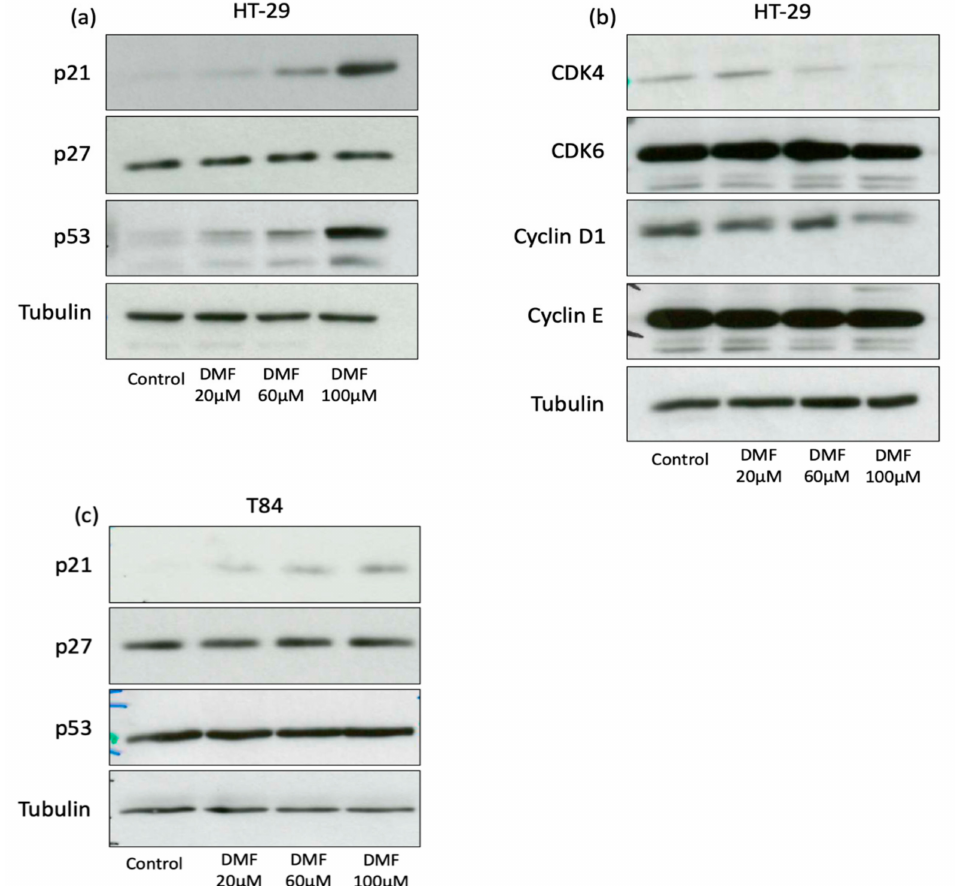
Figure 4. DMF induces p21 in both cell lines and p53 in HT-29 and suppresses CDK4 and cyclin D1 protein expression only in HT-29 cells. Representative Western blot analyses of ( a , b ) HT-29 treated for 24 h with DMF in the indicated concentrations and ( c ) T84 cells treated for 24 h with DMF in the indicated concentrations. DMSO 0.2% served as a solvent control. Comparable results were obtained from at least three independent